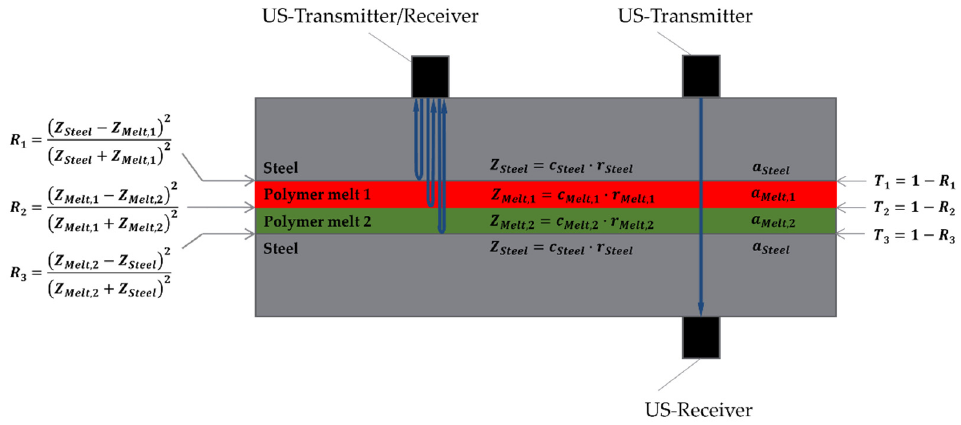
Figure 6. Measurement arrangement for detecting flow instabilities via ultrasound reflection and transmission.